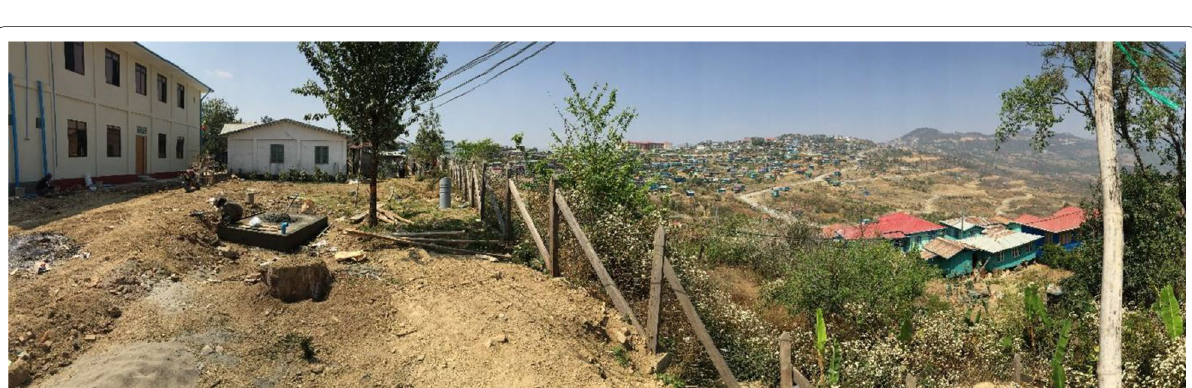
1 is in the upper part of the slope, and is closest to Base station 1, and Sensor 2 is in the lower part of the slope.